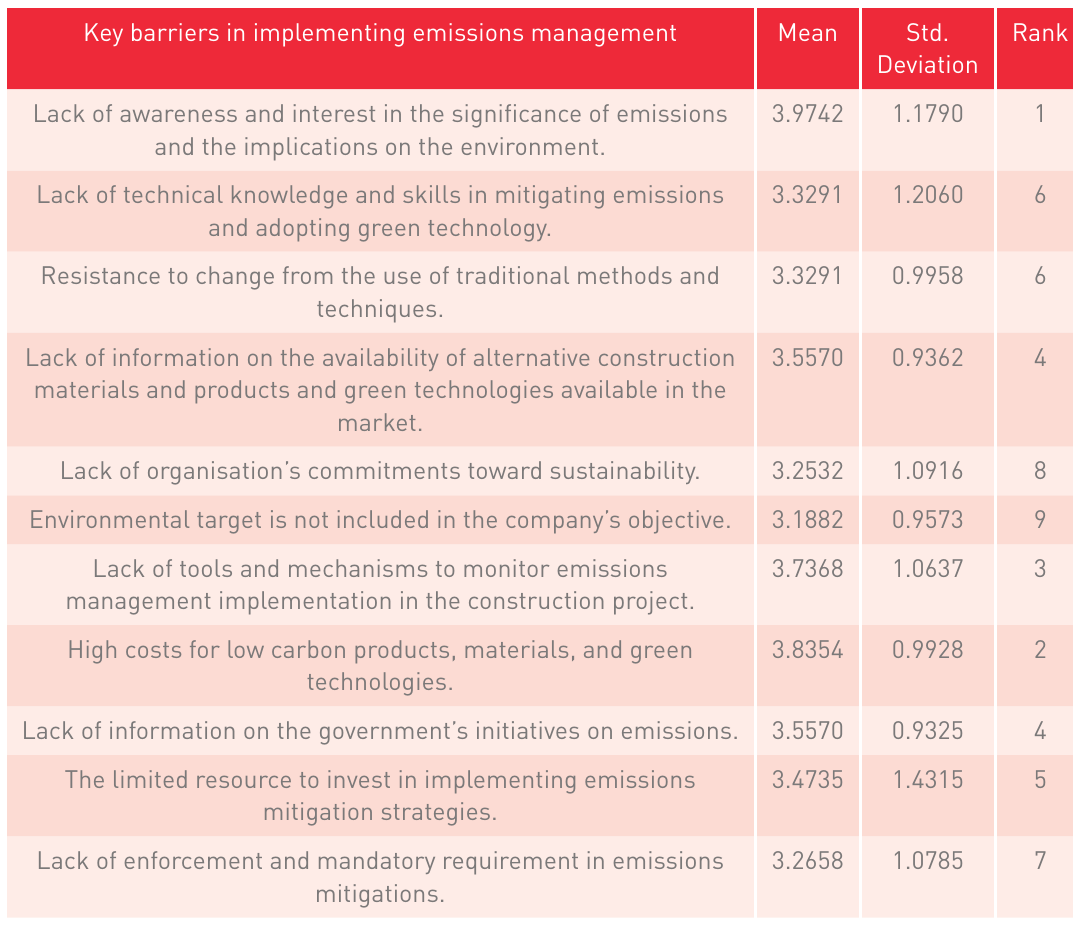
Table 2. Descriptive statistics of the mean (M) and standard deviation (SD) for the barriers to emissions management